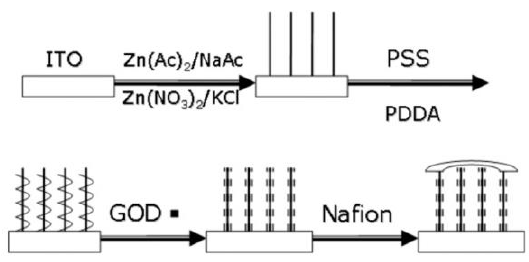
Figure 8. Schematic diagram of self-assembled GOx onto ZnO nanorod arrays synthesized by electrodeposition on ITO. Reprinted from [82] with permission from the Elsevier.